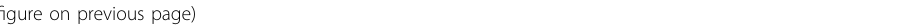
Fig. 2 Knockdown of PCIF1 inhibits the aggressiveness of gastric cancer cells. a Con fi rmation of PCIF1 knockdown in AGS cells with two independent lentivirus-based PCIF1 shRNAs by western blot analysis. b LC-MS/MS quanti fi cation of the m 6 Am/U ratios of mRNAs in control and PCIF1-depleted AGS cells. c MTT assays of AGS cells with control or PCIF1 shRNAs. d Migration analysis of AGS cells with control or PCIF1 shRNAs. Representative images of invaded cells are shown. The invaded cells were counted. Scale bars, 100 μ m. e Western blot analysis of PCIF1 expression in control AGS cells, PCIF1-depleted cells, and PCIF1-depleted cells transfected with wild-type or mutant PCIF1 (N553A) plasmid. f LC-MS/MS quanti fi cation of the m 6 Am/U ratios of mRNAs in AGS cells with the indicated treatments. g MTT assays of AGS cells with the indicated shRNA and plasmids. h Migration analysis of AGS cells with the indicated shRNAs and plasmids. Representative images of invaded cells are presented. The invaded cells were quanti fi ed. Scale bars, 100 μ m. i Con fi rmation of PCIF1 depletion in GCSR1 cells with lentivirus-based control or PCIF1 shRNAs by western blotting. j , k Control and PCIF1-depleted GCSR1 cells were subcutaneously injected into BALB/C nude mice. The tumor volume was measured every week, and the growth curves are shown. The images of tumors in each group are presented ( n = 5). Scale bar, 1 cm. l – n Control and PCIF1-knockdown GCSR1 cells were intravenously injected into SCID mice and lung metastases (black arrows) were measured. The lung was weighted at the end of experiment. Gross lung and representative H&E images are presented ( l ). Statistics analyses of lung weight ( m ) and metastatic nodule number ( n ) are shown. Scale bars, 1 cm. o – q PDX-GC cells stably expressed a luciferase reporter gene were infected by lentivirus-based shRNA targeting PCIF1, and then overexpressed with wild-type PCIF1 or its catalytically inactive N553A mutant. Western blotting with the indicated antibodies is shown ( o ). These PDX-GC cells were intravenously injected into SCID mice. Representative bioluminescence images are also presented ( p ). Quanti fi cation analyses of bioluminescent images of lung metastases are shown ( q ). Data are expressed as means ± SD. * P < 0.05, ** P < 0.01, *** P < 0.001, Student ’ s t- test ( b – d , f – h , k ), Mann – Whitney test ( m , n , q